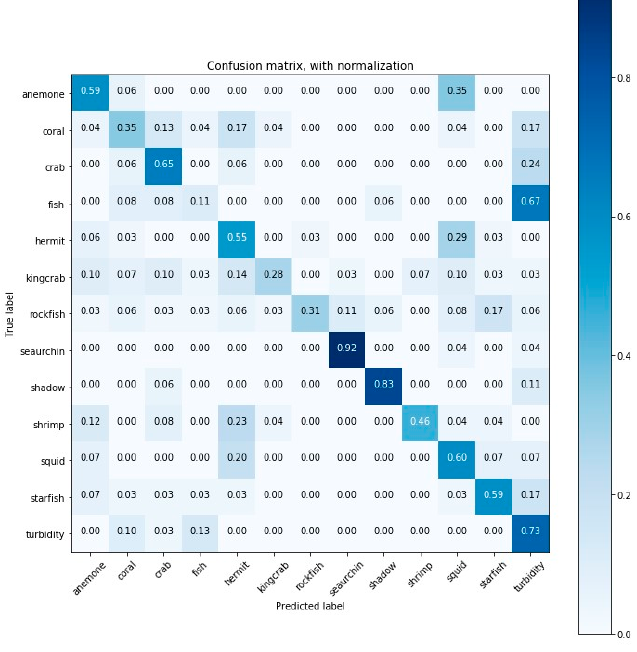
Figure A3. Confusion matrix for the classification results (accuracy) obtained by K-nearest neighbors (K-NN) (k = 39).